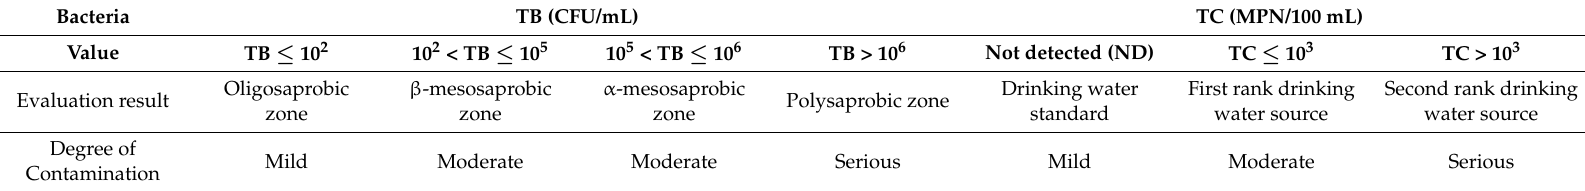
Table 2. Criteria used to evaluate the level of microbial contamination in the Xincang River